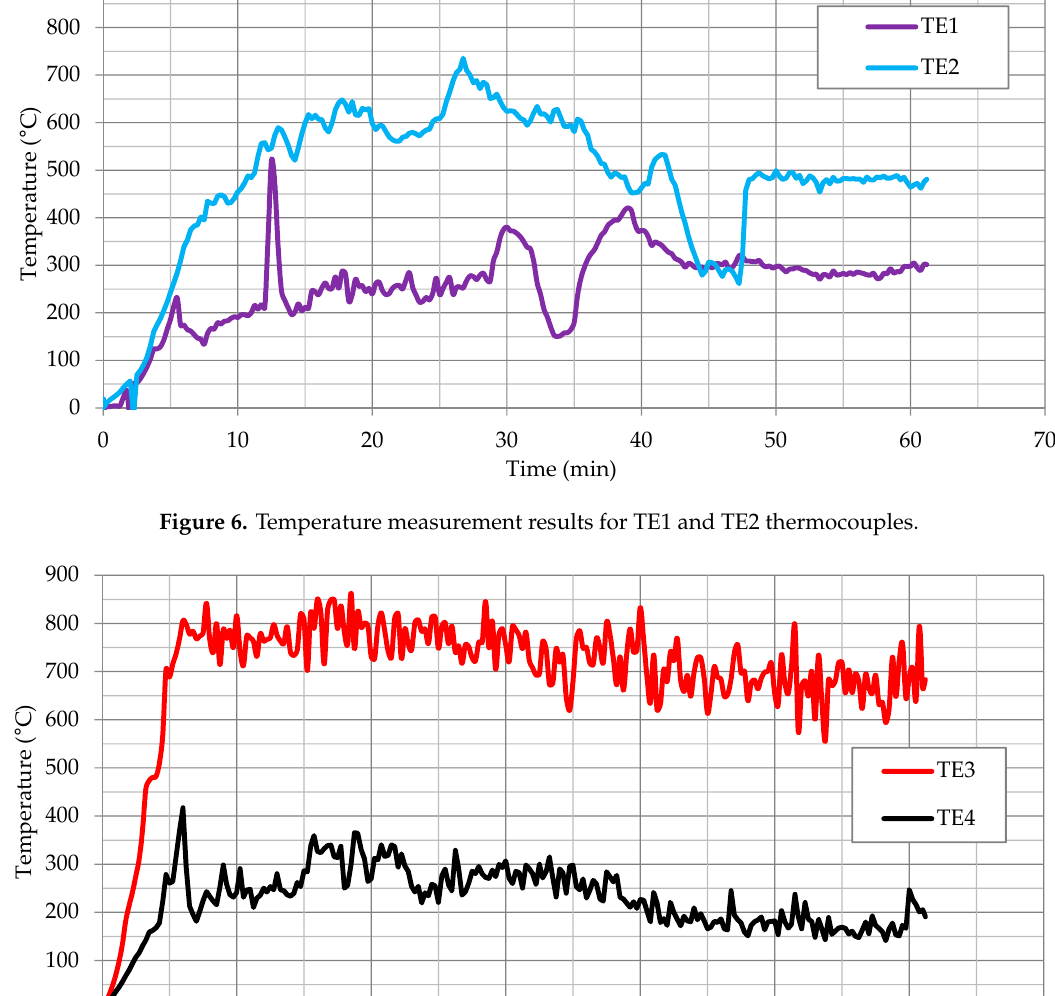
Figure 5. Ventilated facade model view after the fire source was extinguished and the test was completed.